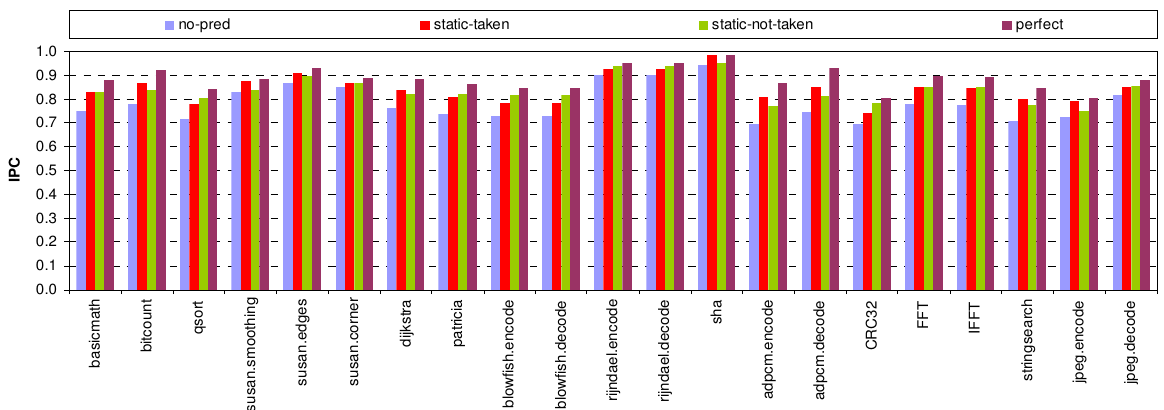
Figure 5. IPC performance of the base processor using different branch prediction techniques (no-pred=no branch prediction, static-taken=static predictor with default taken prediction, static-not-taken=static predictor with default no-taken prediction, perfect = perfect branch prediction).